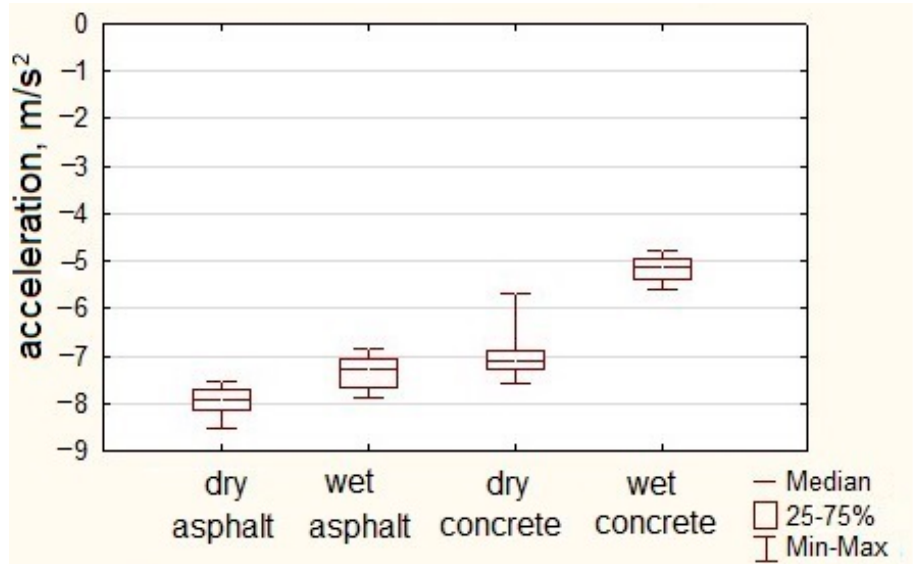
Figure 4. Longitudinal acceleration of urban bus during braking.